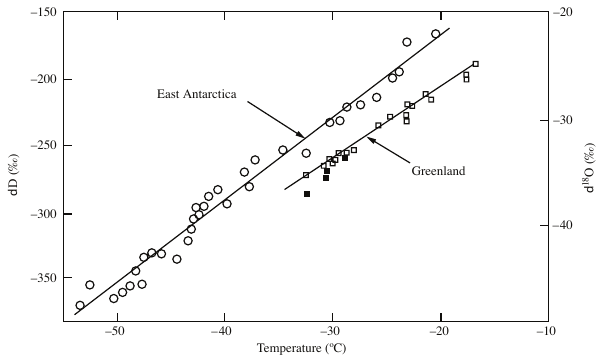
Fig. 5. Isotope content of snow versus local temperature (an- nual average). Antarctic data ( δ D, left scale) are from Lorius and Merlivat (1977) and Greenland data ( δ 18 O, right scale) are from Johnsen et al. (1989).